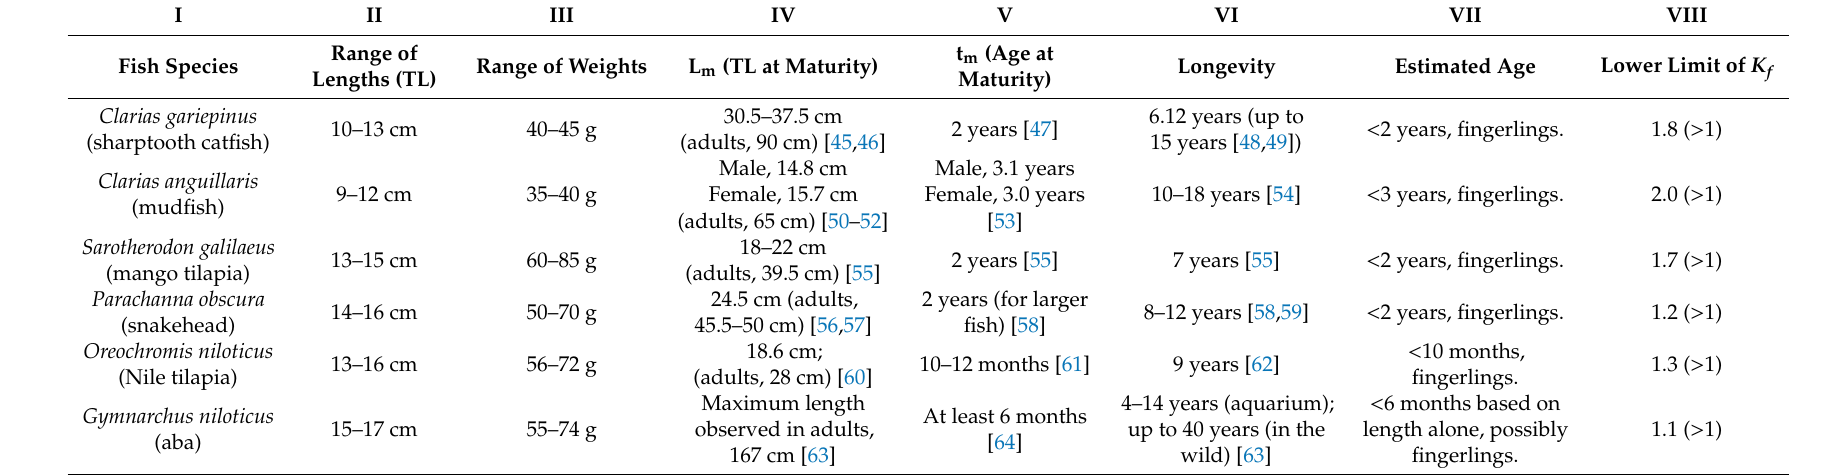
Table 4. Biological data on fish caught from the Owena